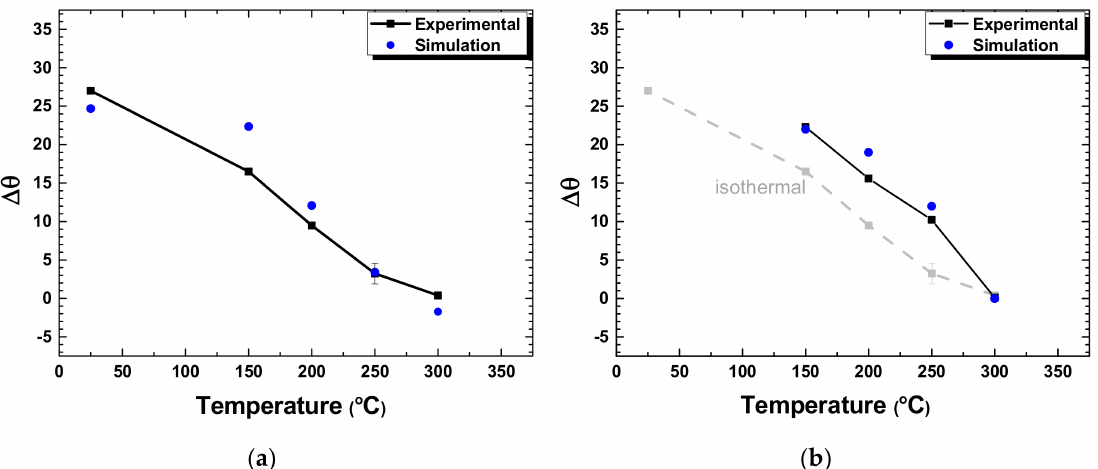
Figure 5. The effects of temperature on the experimental values of ∆ θ under ( a ) isothermal and ( b ) non-isothermal conditions.